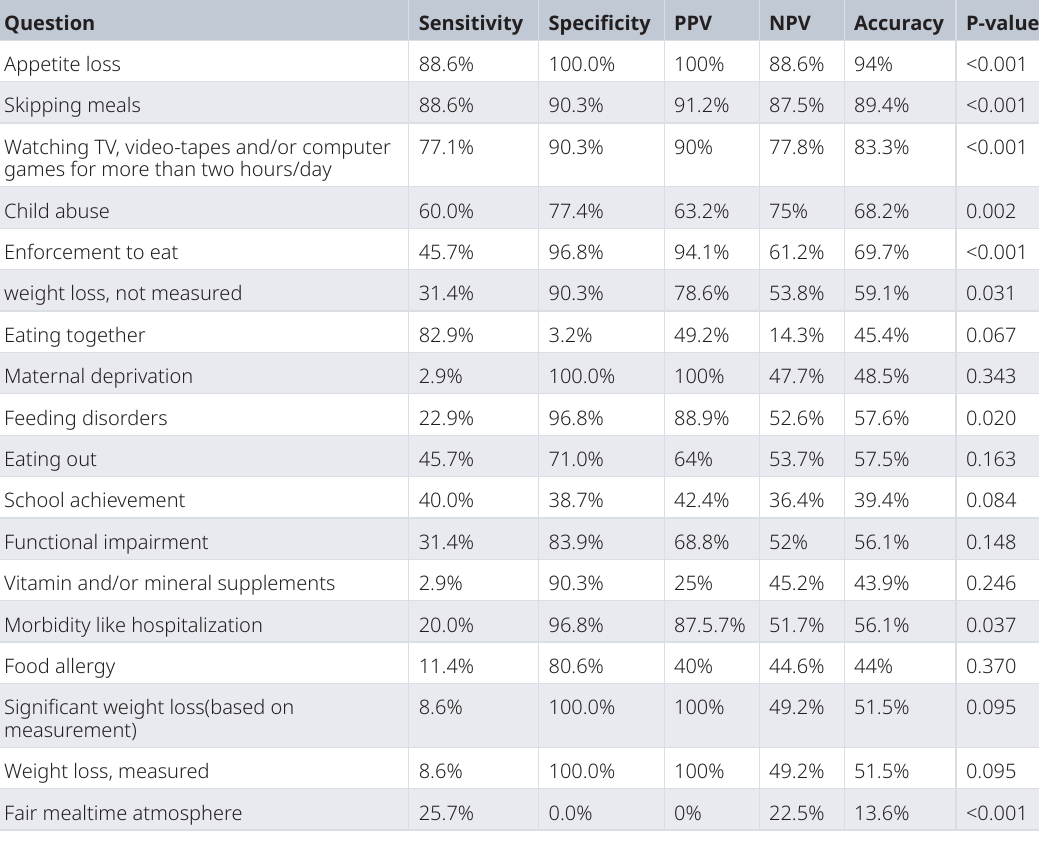
Table 5. Comparison between the screening questions and the subjective global assessment in the early childhood group.